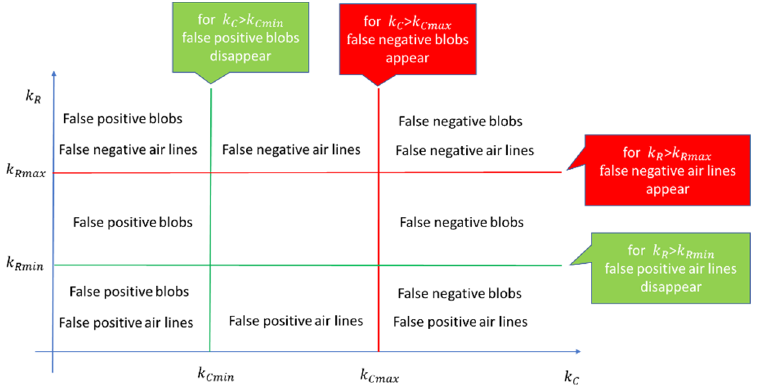
Figure 11. Scheme for identifying the parameters k Cmin , k Cmax , k Rmin , k Rmax for each frame in the tuning phase.